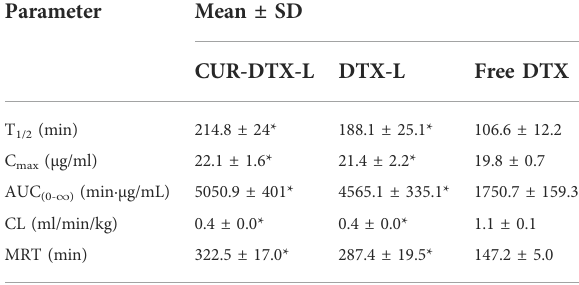
TABLE 3 Pharmacokinetic parameters of DTX in formulations and free drugs ( n = 6). Parameter